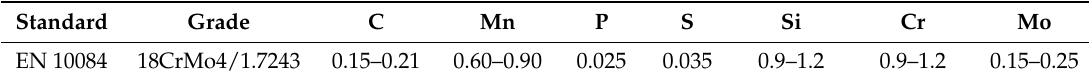
Table 1. Chemical composition of 18CrMo4